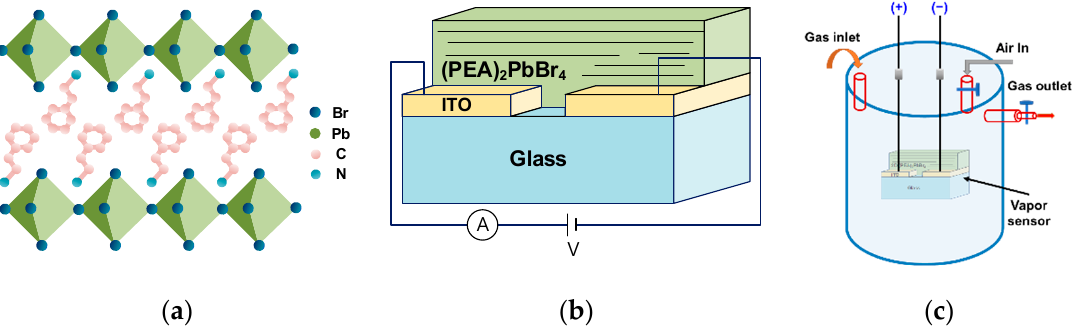
Figure 1. ( a ) Crystal structure of 2D-(PEA) 2 PbBr 4 ; ( b ) Schematic diagram of the 2D-(PEA) 2 PbBr 4 alcohol vapor sensor; ( c ) Gas sensing measurement setup schematic.